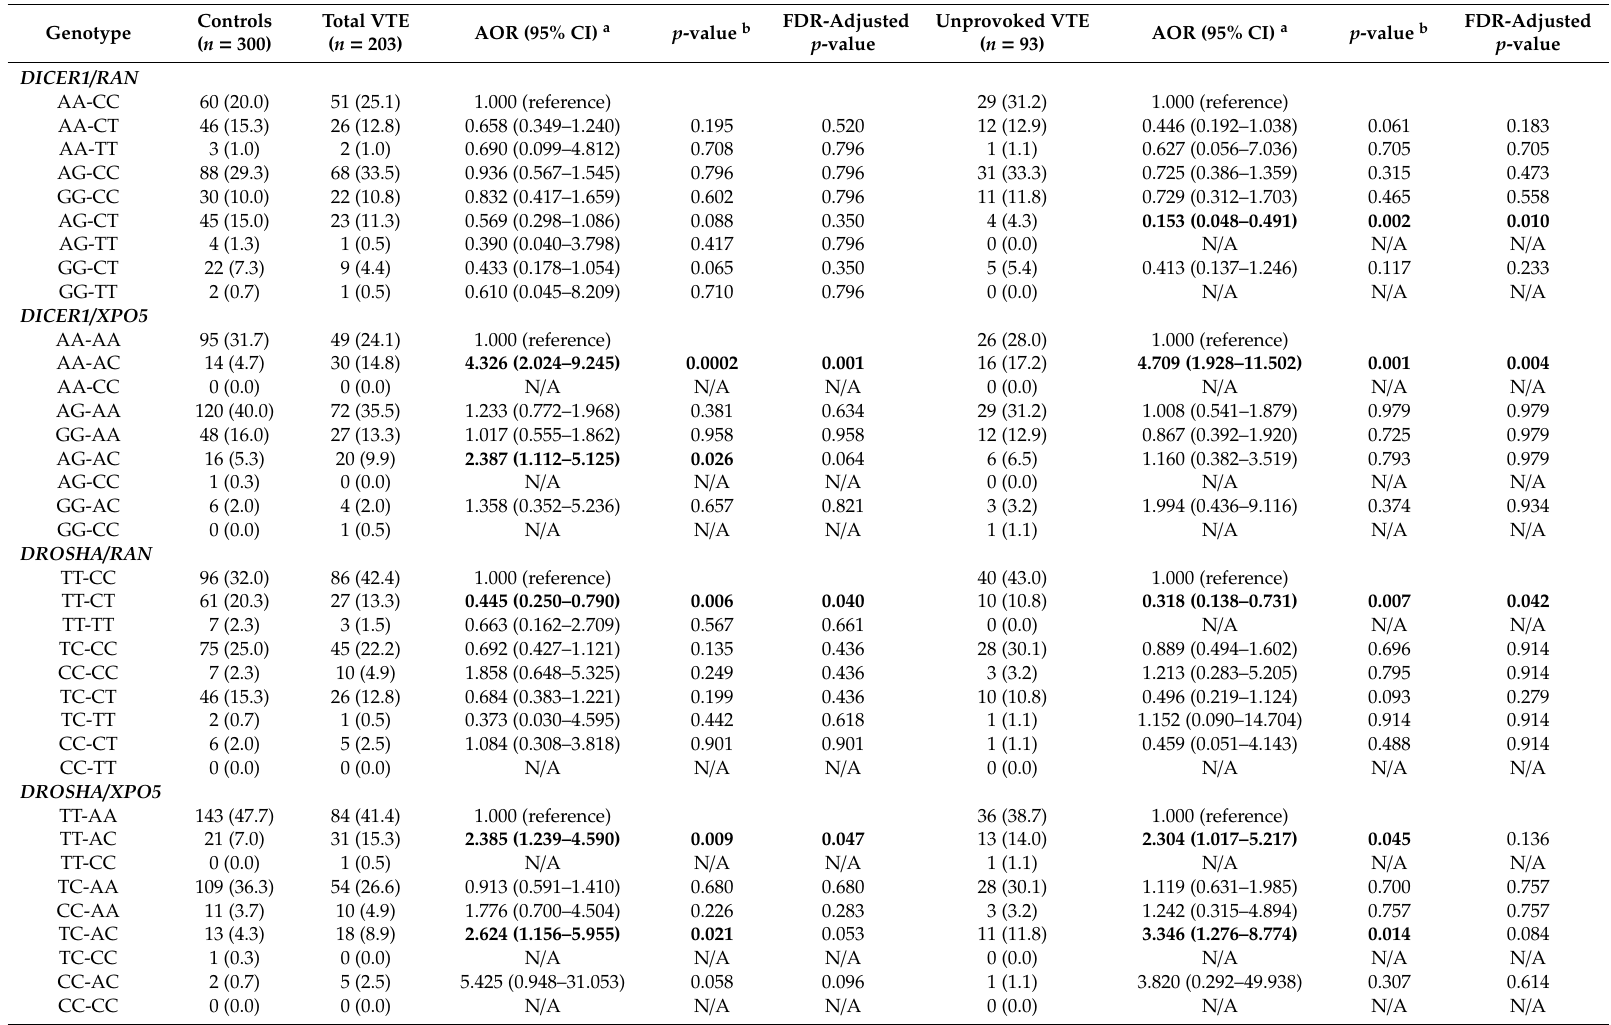
Table 3. Genotype combination analysis for DICER1 , DROSHA , RAN , and XPO5 polymorphisms in VTE patients and control